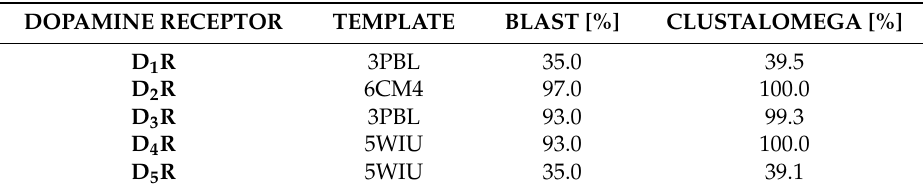
Table 2. Identity between DRs in study and their corresponding templates calculated with BLAST [40] and ClustalOmega